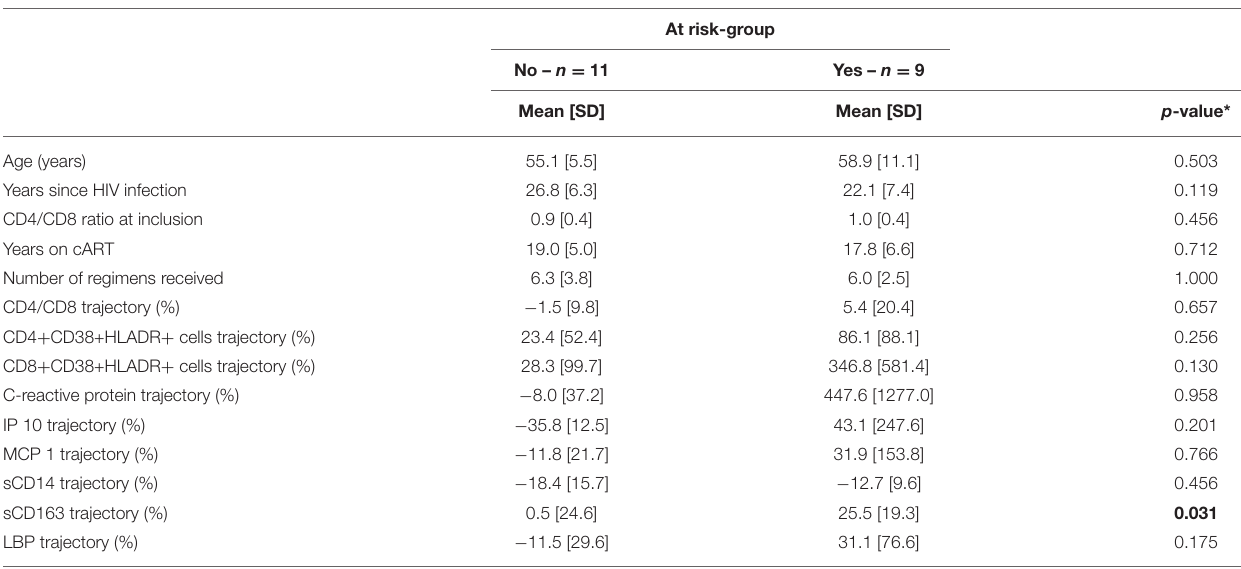
TABLE 1 | Comparison between subjects at low and high risk of immune activation.